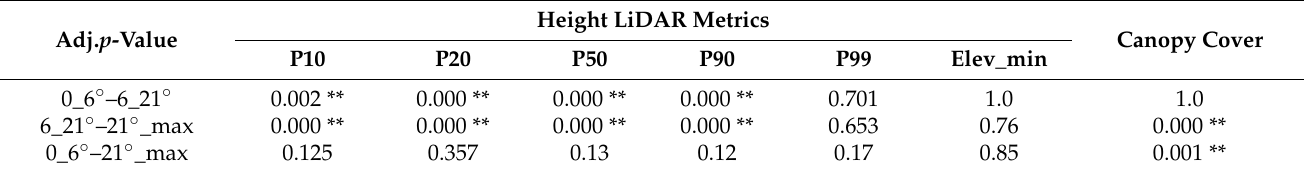
Table 4. Results of multiple tests of common LiDAR metrics at different scanning